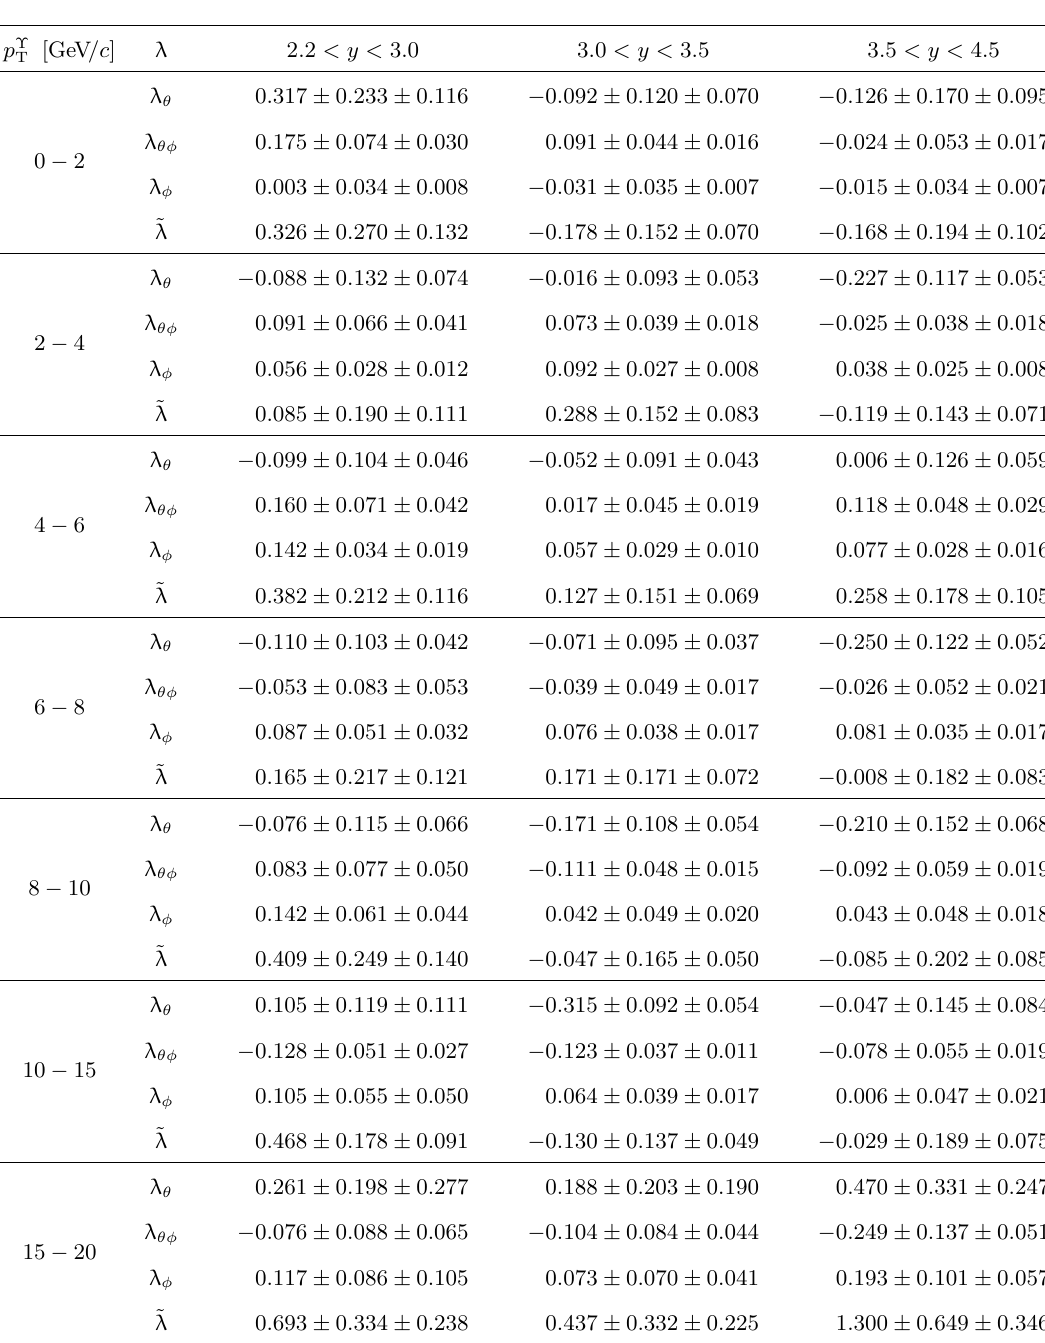
Table 24 . Values of (cid:21) (cid:18) , (cid:21) (cid:18)(cid:30) , (cid:21) (cid:30) and ~ (cid:21) measured in the GJ frame for the (cid:7)(3S) produced at p s = 7 TeV. The (cid:12)rst uncertainty is statistical and the second